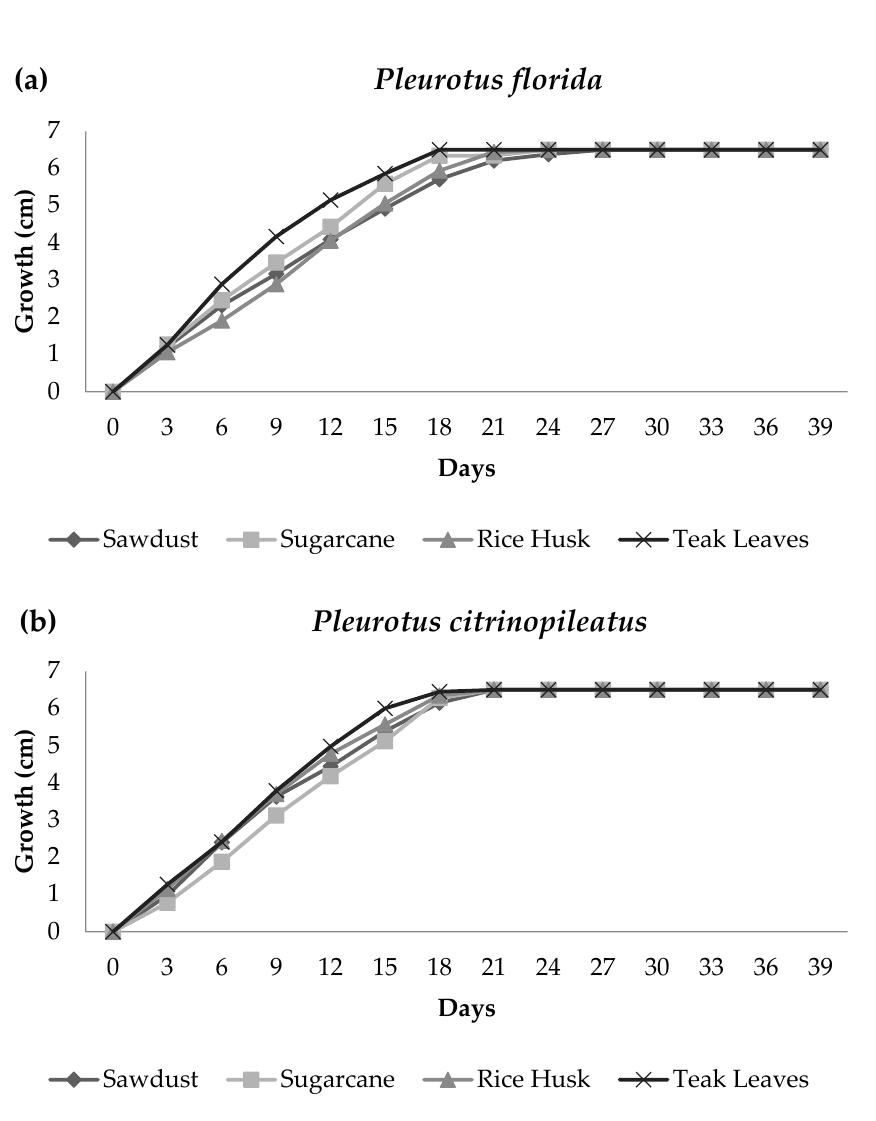
Figure 1. Growth rate of ( a ) Pleurotus florida fungal foam ( b ) Pleurotus citrinopileatus fungal foam in different substrates. Table 1. Lignin content of the substrates